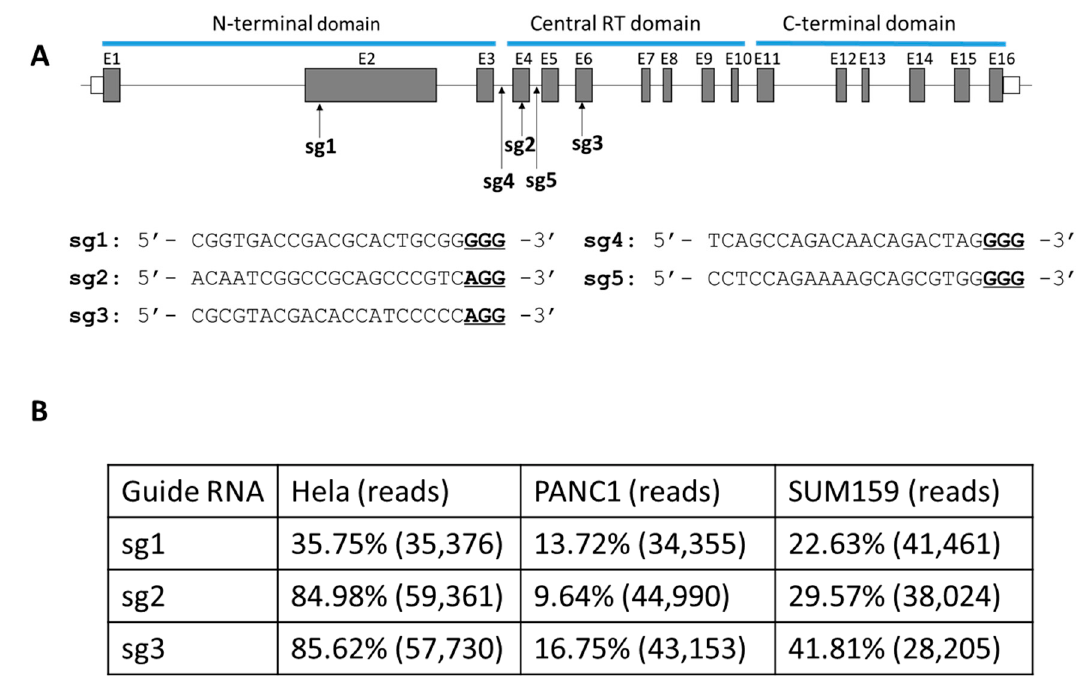
Figure 1. Design and efficiencies of Cas9 gRNAs targeting TERT. ( A ) Top: illustration of gRNAs (sg1 to sg5) targeting TERT. E#: Exon#. Bottom: gRNA sequences. Underlined: PAM. ( B ) Indel efficiencies of sg1, sg2 and sg3 determined by deepseq in Hela, PANC1 and SUM159 cells. Total deepseq reads for each locus were shown in parentheses.